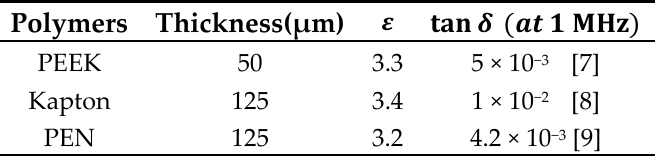
Table 1. Dielectric characteristics of the polymers substrates.